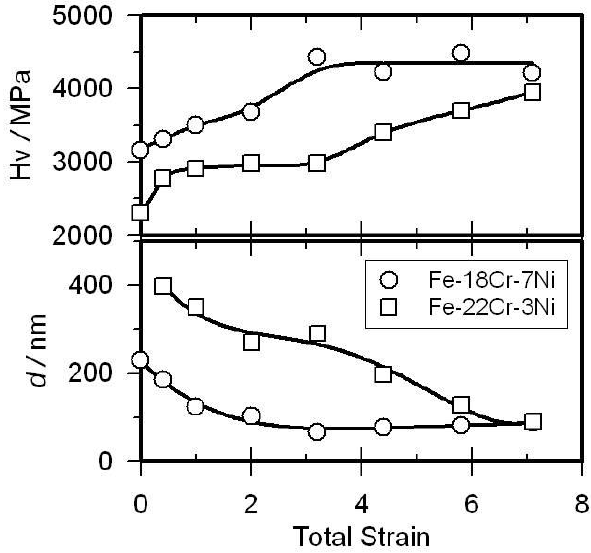
Figure 27. Effect of initial microstructure on the hardness (Hv) and the transverse (sub)grain size (d) in Fe-18%Cr-7%Ni and Fe-22%Cr-3%Ni stainless steels subjected to cold rolling/swaging [29].